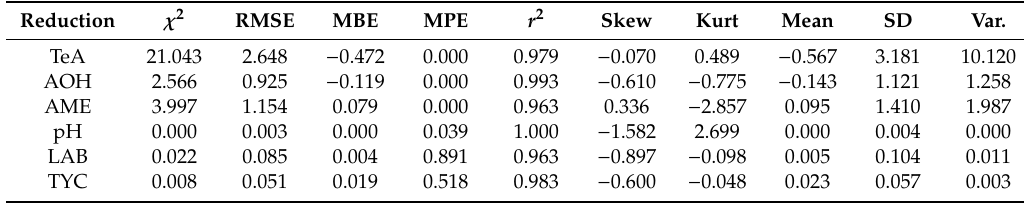
Table 4. The ’goodness of fit’ tests for TeA, AOH and AME reduction models and pH value, total LAB and total yeast count prediction